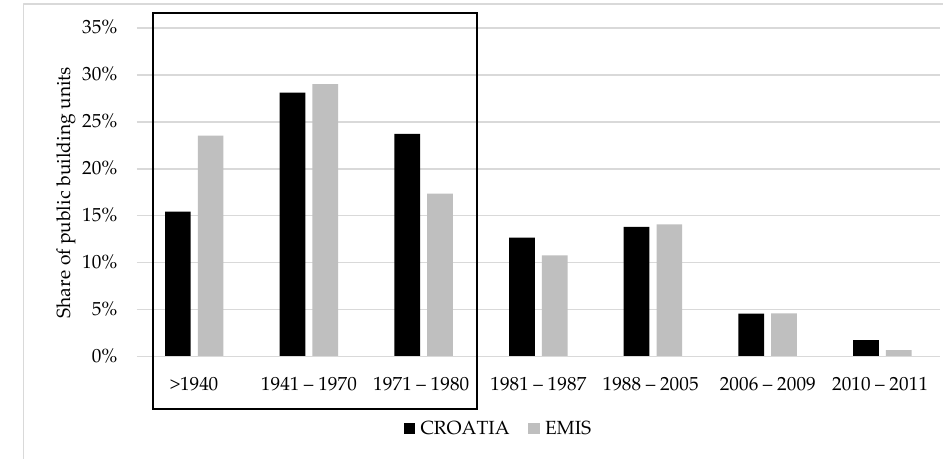
Figure 1. Share of public building units in Croatia and in the Energy Management Information System (EMIS) database according to the year of construction.